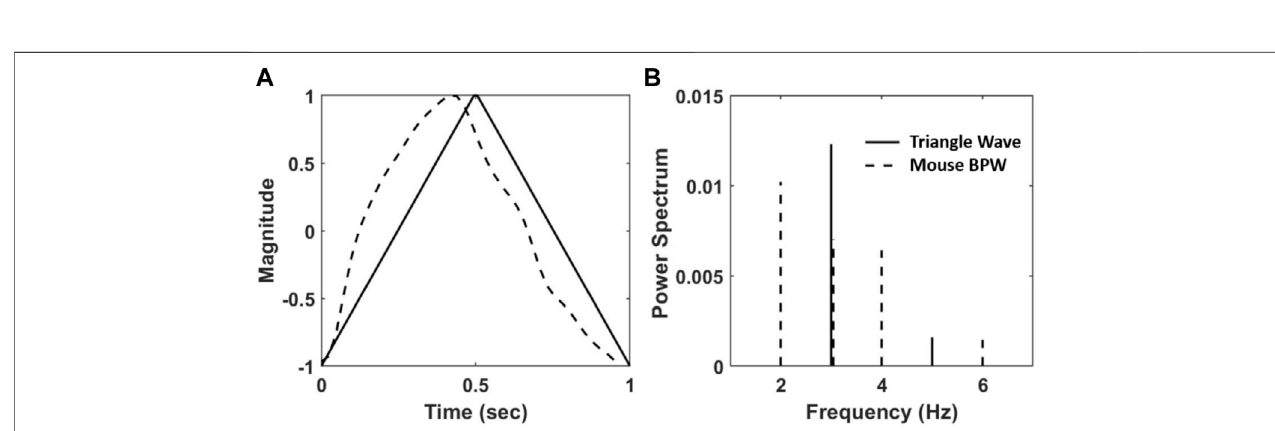
FIGURE 2 | (A) A triangular wave (solid line) and a normalized BPW from radiotelemetry (dashed line). (B) The normalized power spectrum, calculated as the squared fraction of Fourier coef fi cients at integer multiple of the fundamental frequency of the waveforms in (A) at 1